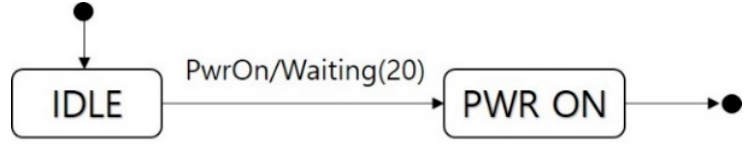
Figure 1. An example of state machine.